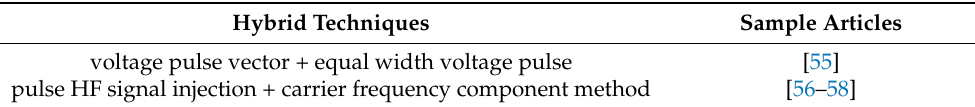
Table 3. Hybrid approach sample papers. Hybrid Techniques Sample